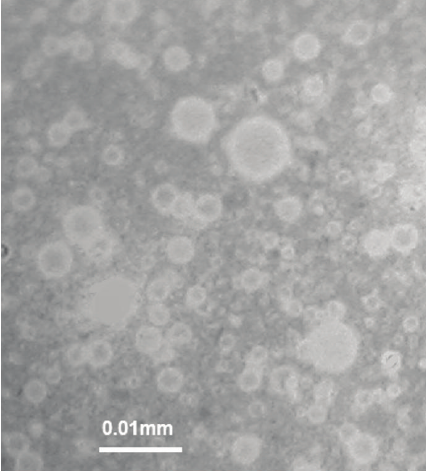
Figure3:Anopticalmicrographoftheemulsionwitha1 : 1oil/water volume